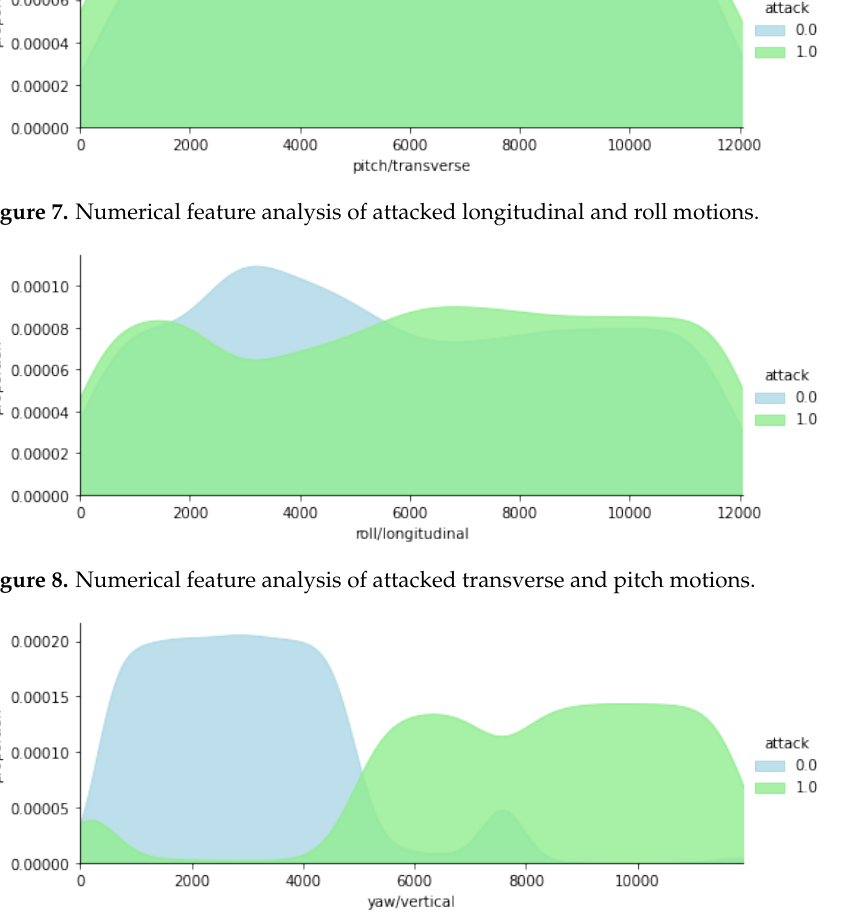
Figure 9. Numerical feature analysis of attacked vertical and yaw